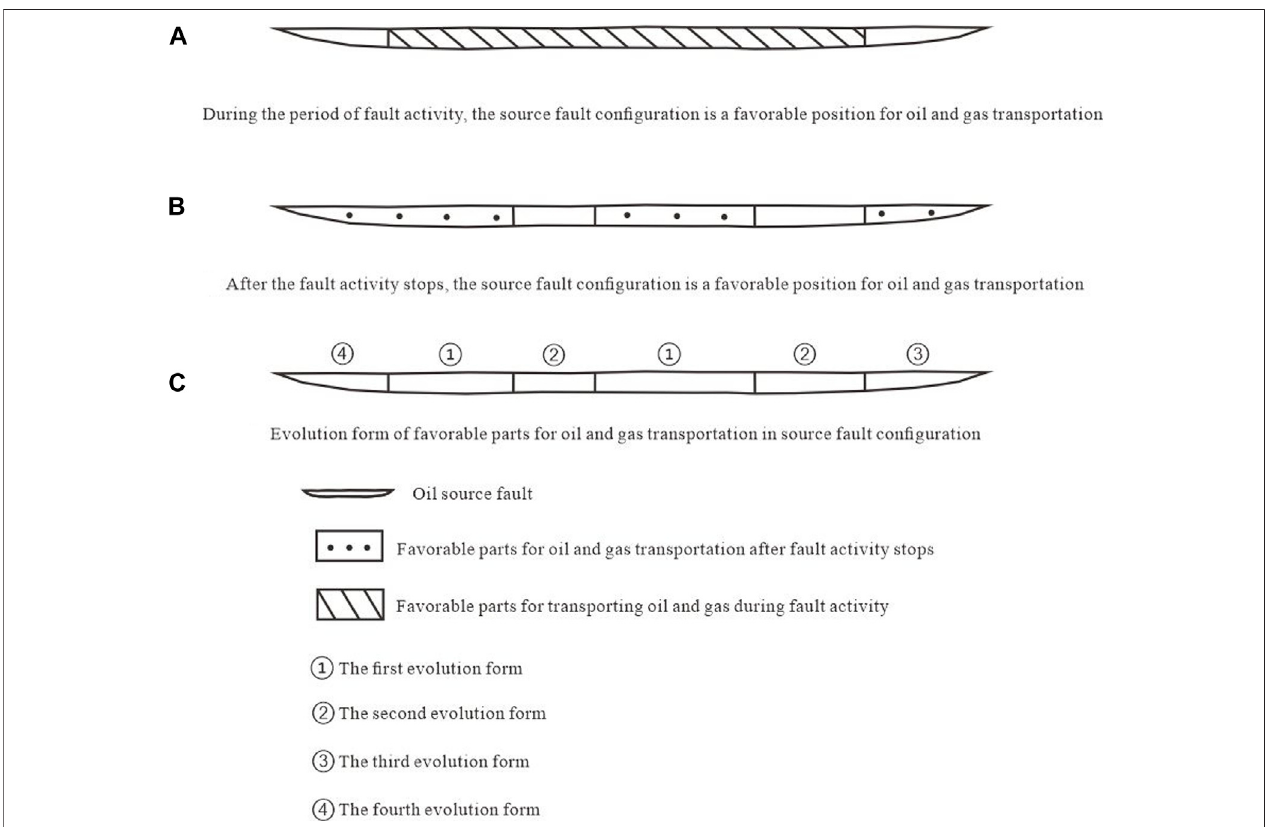
FIGURE 1 | Schematic diagram of evolution form of favorable position for transporting oil and gas with source-fault con fi guration.